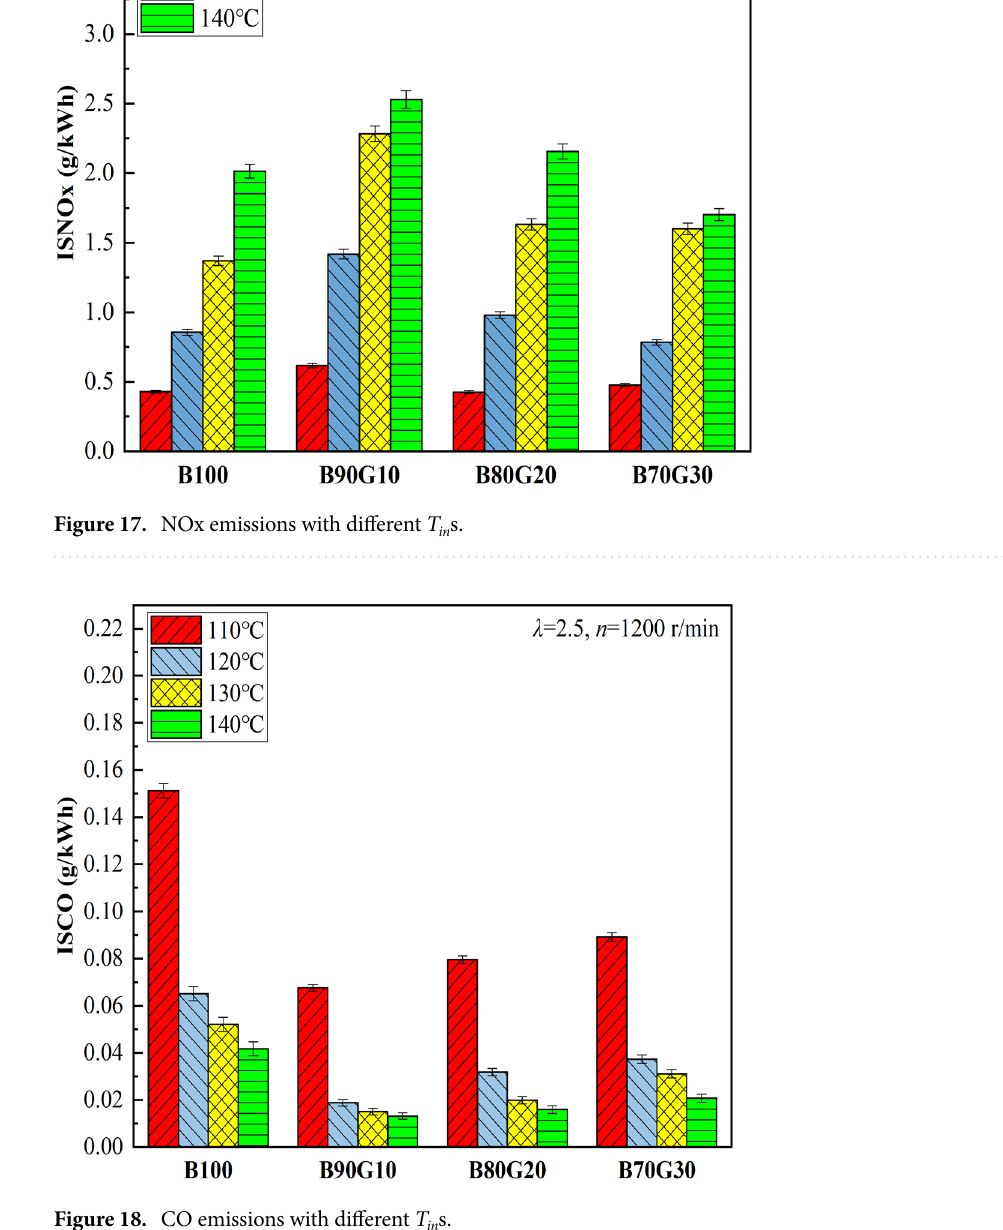
Figure 18. CO emissions with different T in